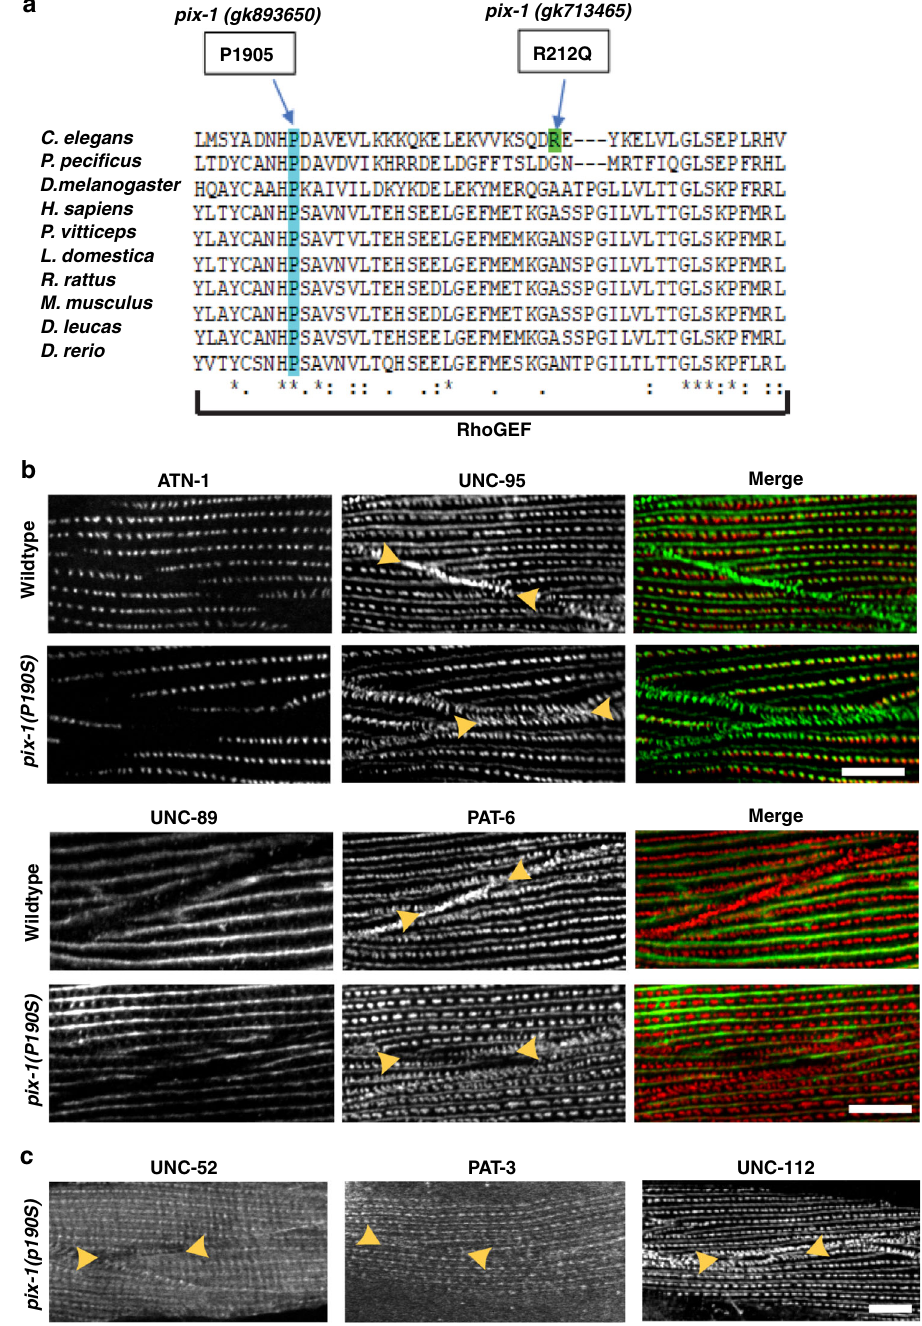
Fig. 9 P190 is conserved in PIX RhoGEF domains and required for PIX-1 function at muscle cell boundaries. a PFAM alignment of RhoGEF domain sequences of PIX proteins from 10 species showing that P190 is absolutely conserved. In contrast, R212 is not conserved, which might explain why pix-1 (gk713465) [R212Q] has no obvious phenotype. b Confocal microscopy of wild type and pix-1(gk893650) [P190S] mutant co-stained with antibodies to ATN-1 ( α -actinin) and UNC-95 (top two rows), and co-stained with UNC-89 (obscurin) and PAT-6 ( α -parvin) (bottom two rows). Note that in pix-1 (gk893650) , at the muscle cell boundary, the two halves of the zipper are separated, whereas in wild type they are together. c Confocal imaging of pix-1 (gk893650) [P190S] stained with antibodies to UNC-52 (perlecan), PAT-3( β -integrin) or UNC-112 (kindlin). Note that these IAC proteins also show reduced or disrupted localization at muscle cell boundaries. Arrowheads bracket a muscle cell boundary. Each image is a representative image obtained from at least 2 fi xation and immunostaining experiments, and imaging at least three different animals of each strain. Scale bar, 10 μ boundary defects in loss of function for pix-1, git-1, ced-10 , and pak-1 , and from overexpression of pix-1 . These results could be cycling. Therefore, we have considered the hypothesis that PIX-1 interpreted as indicating a requirement for cycling of the is required at MCBs because muscle cell boundaries are RacGTPase rather than its absolute activity. If IAC assembly more dynamic that M-lines and dense bodies. However, our required the PIX-1 pathway, then IACs that are assembling and